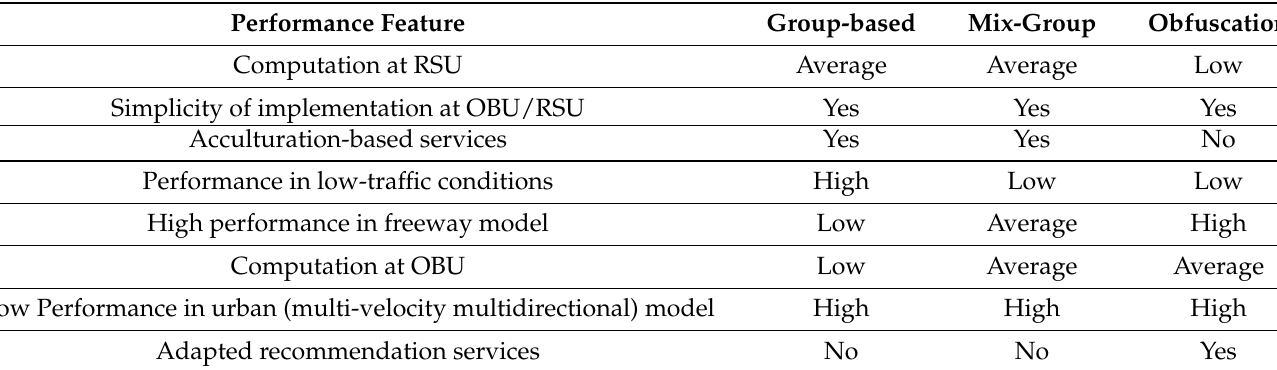
Table 3. Comparison between VANETs location privacy